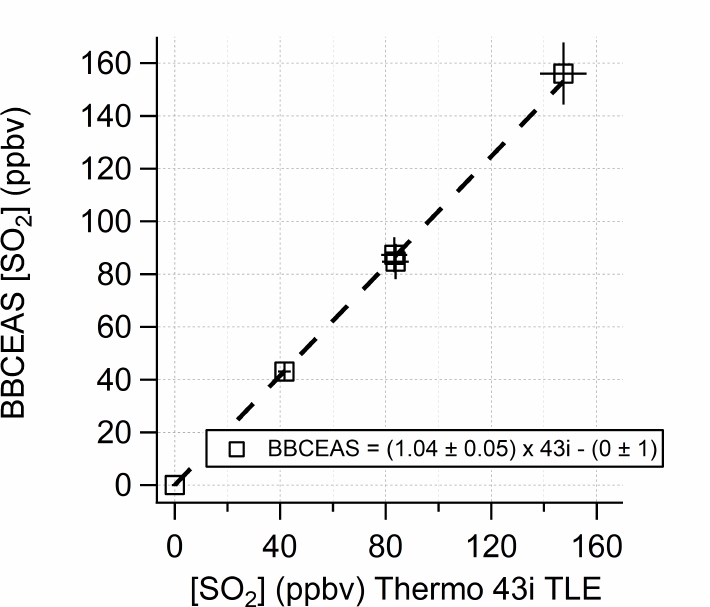
Figure 7. Correlation of BBCEAS (boxes) measured SO 2 with respect to that measured by the TECO 43i-TLE. The linear fit equation and uncertainties are included in the graph.